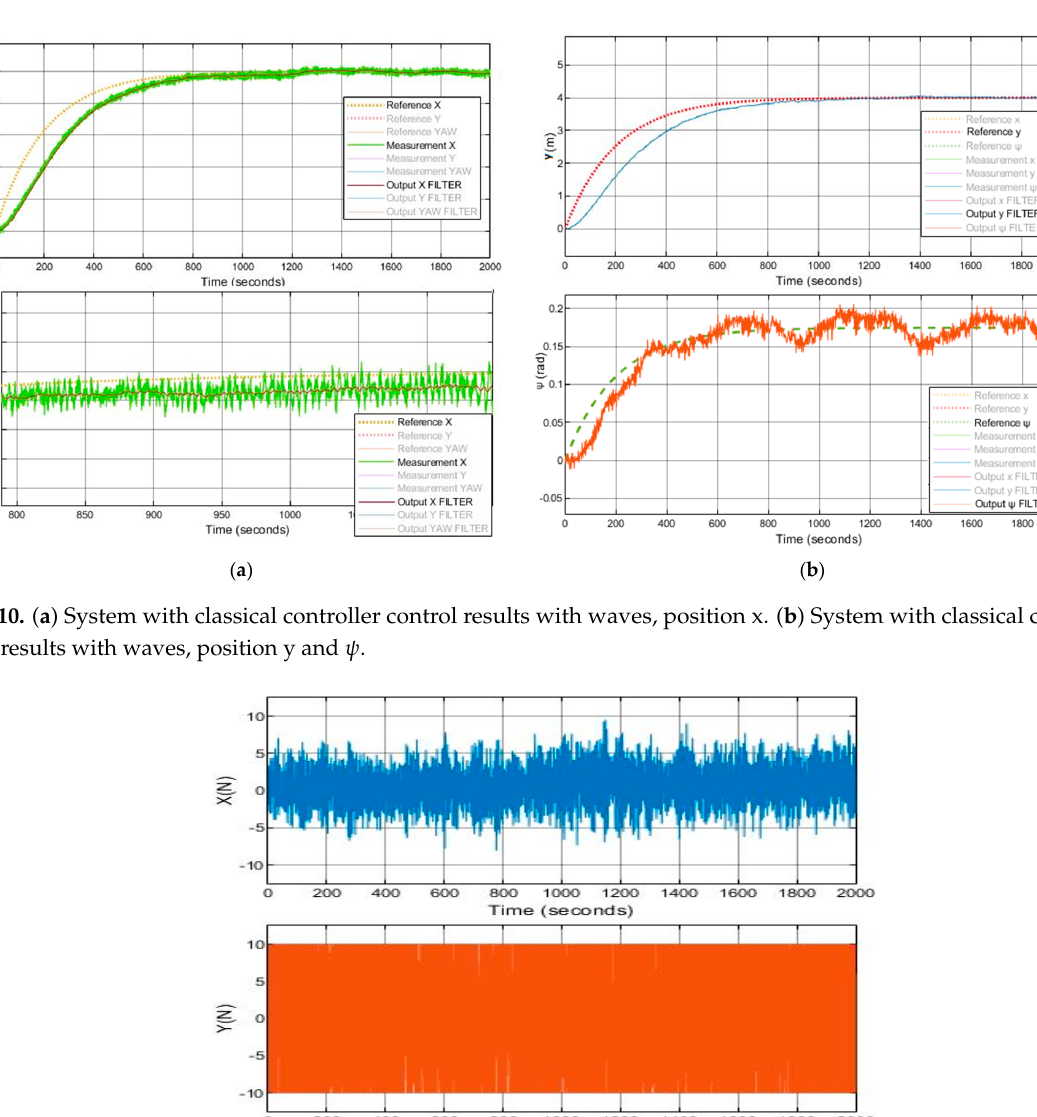
Figure 11. System with classical controller control result with waves. Force in X , Y and N .